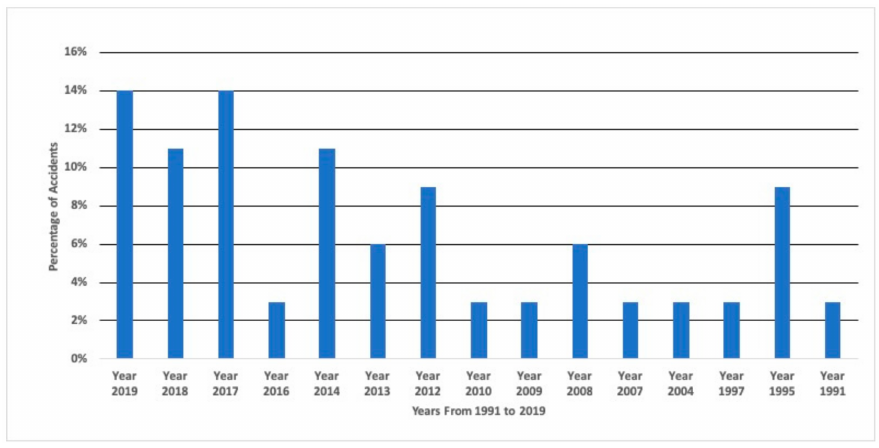
Figure 2. The distribution of accidents’ percentages based on years.